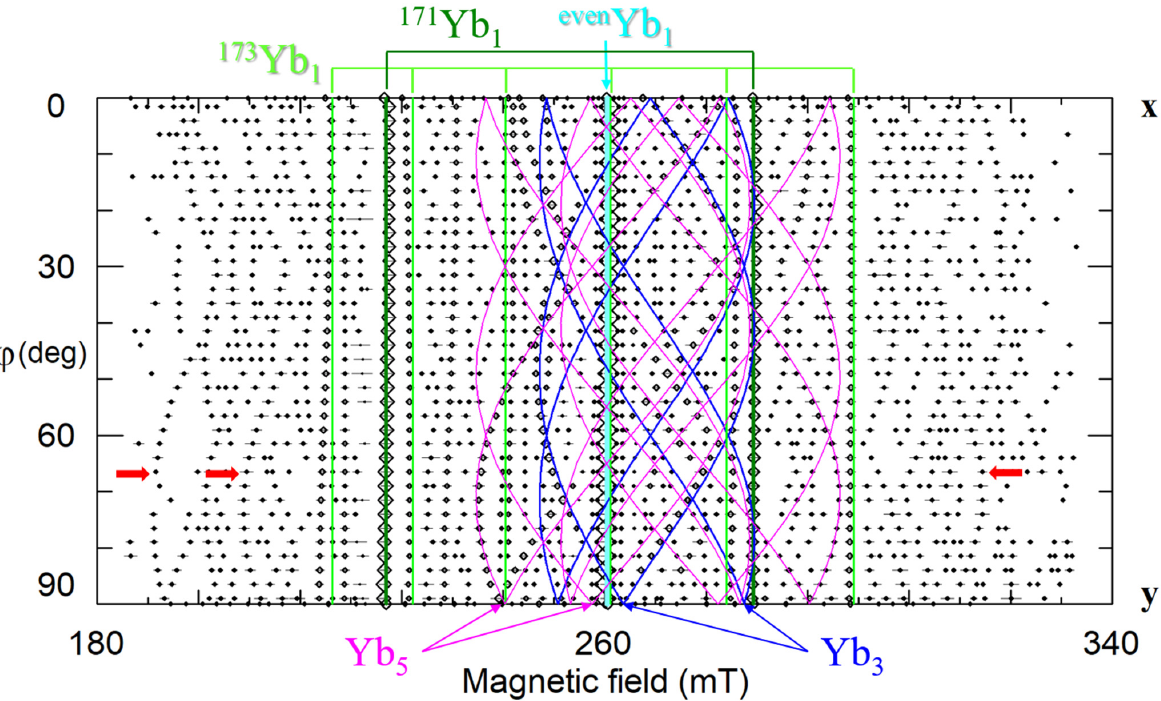
Figure 23. Angular dependence of EPR spectra of Yb 3+ in stoichiometric LN, xy plane, ν = 9.86 GHz. Red arrows—lines of hyperfine structure for Yb 5 centers.